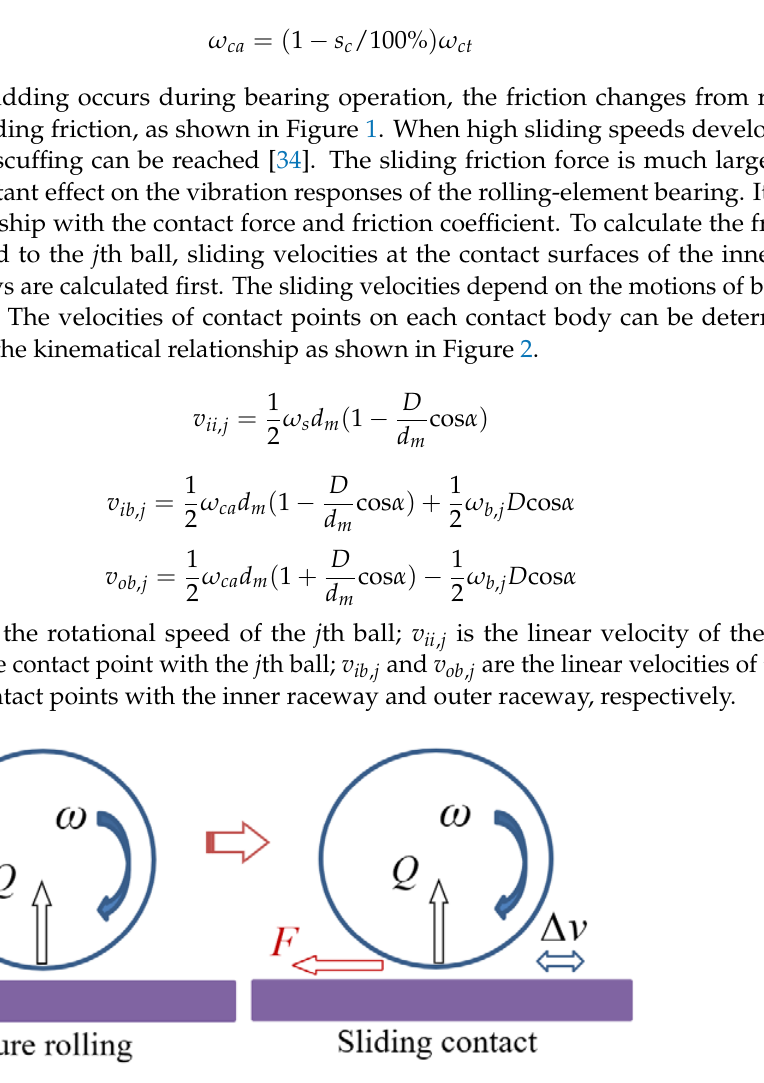
Figure 1. Sliding friction force due to skidding.